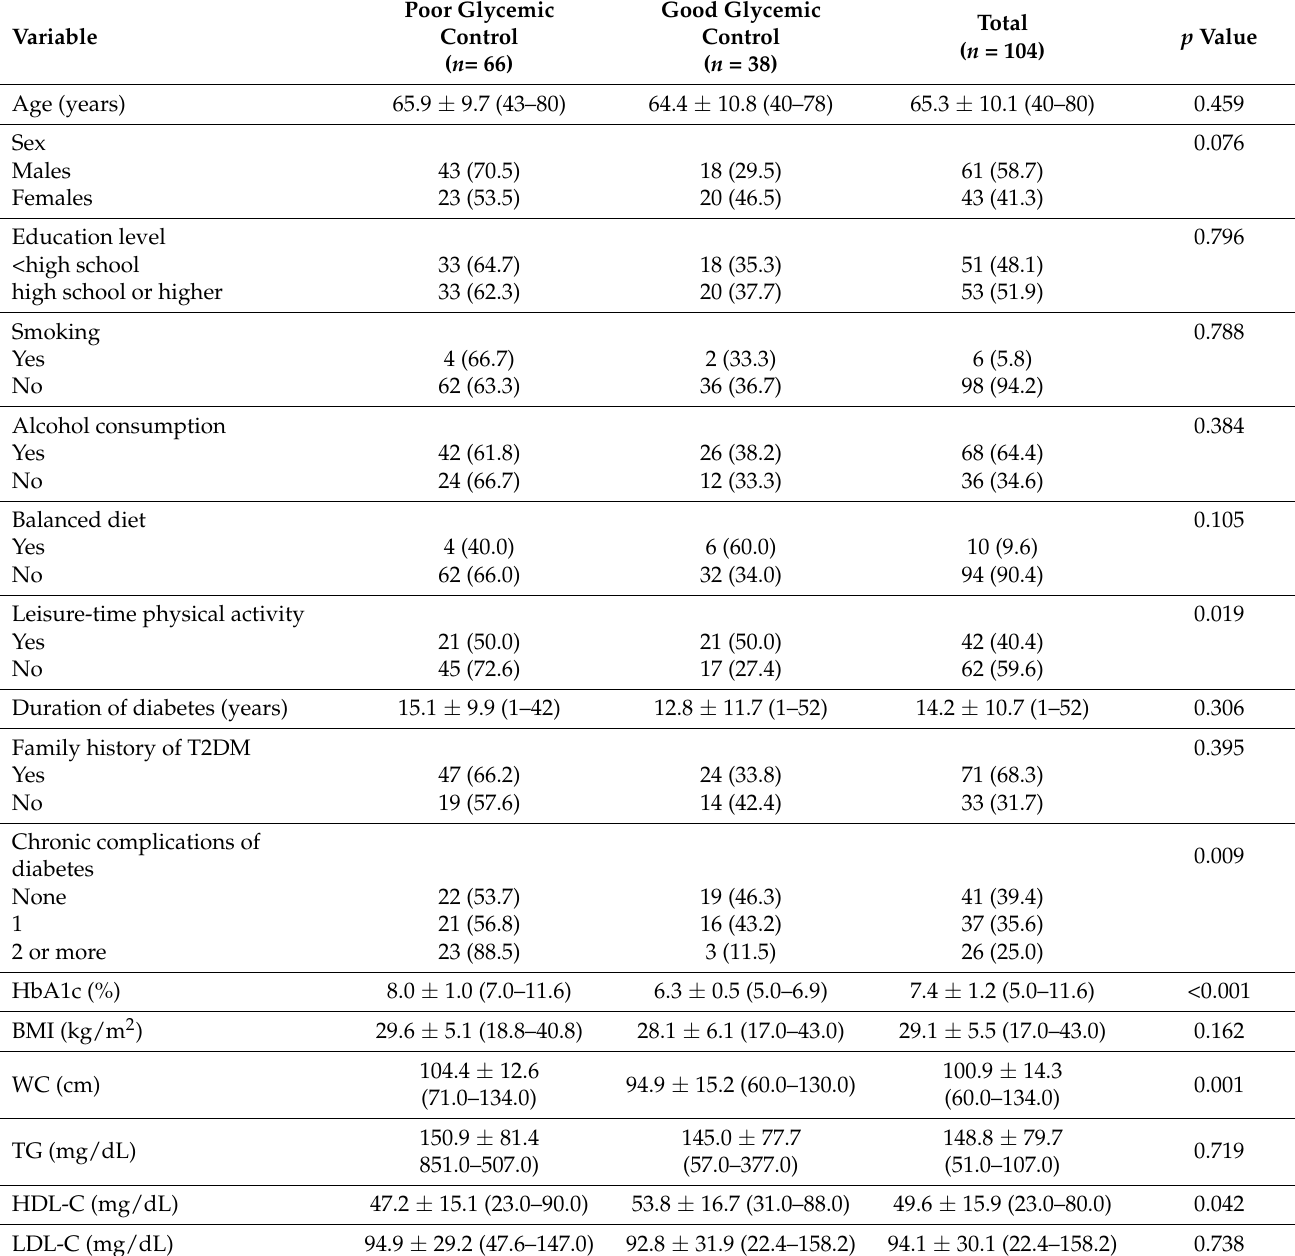
Table 1. Sociodemographic and clinical characteristics of T2DM patients (mean ± SD (range) or n (%)) according to the glycemic